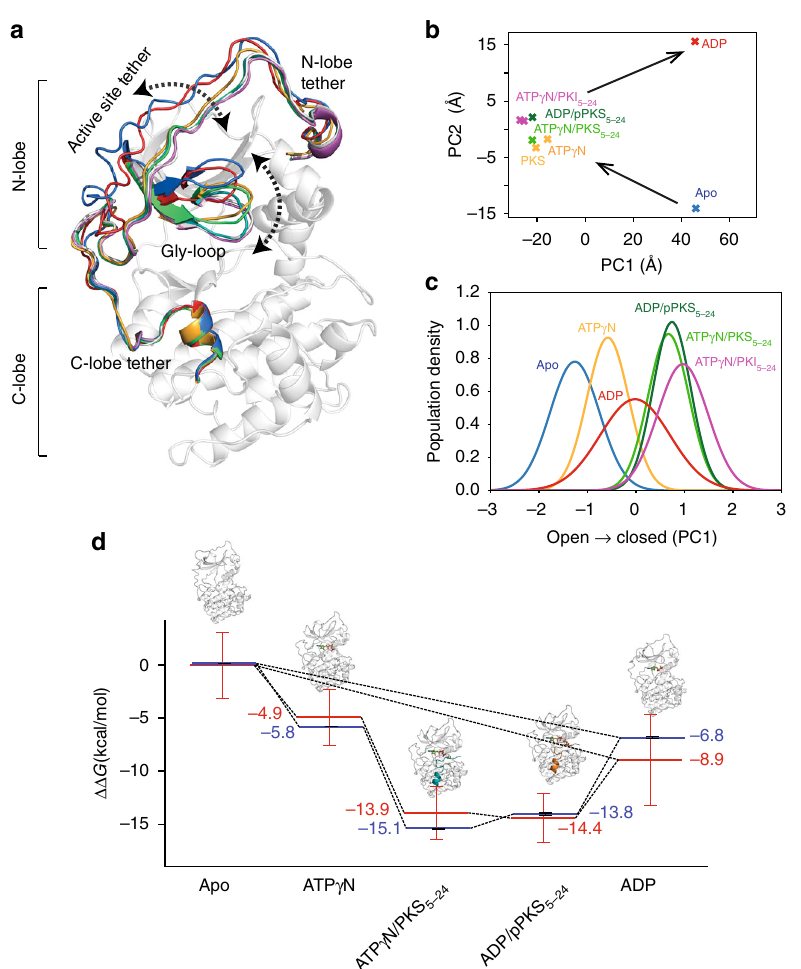
Fig. 1 Conformational transition of PKA-C during turnover. a Superposition of the X-ray crystal structures of PKA-C in the apo (PDB code: 4NTS),